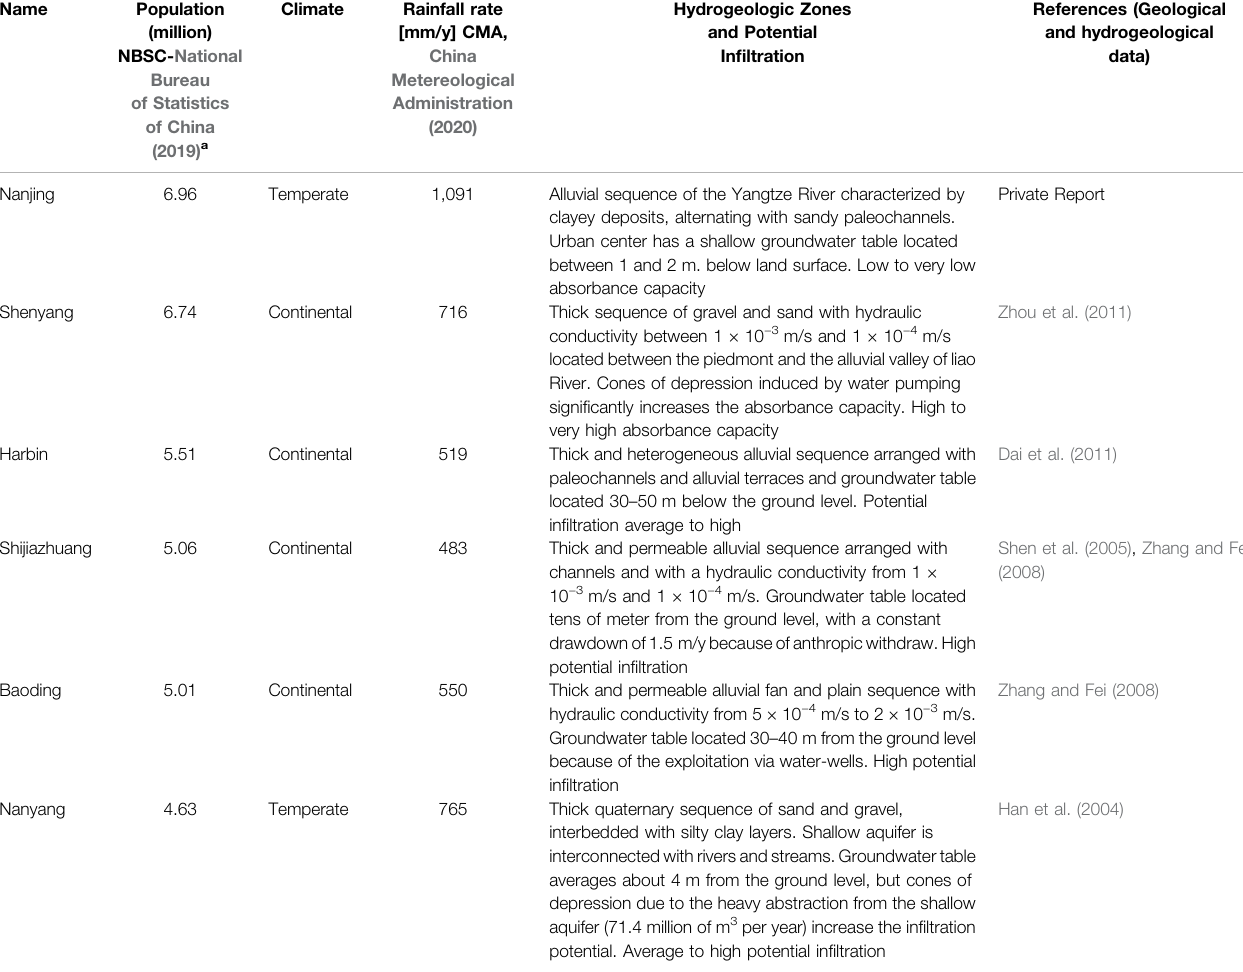
TABLE 1 | ( Continued ) Hydrogeological characteristics and absorbance capacity of the 17 most populous Chinese